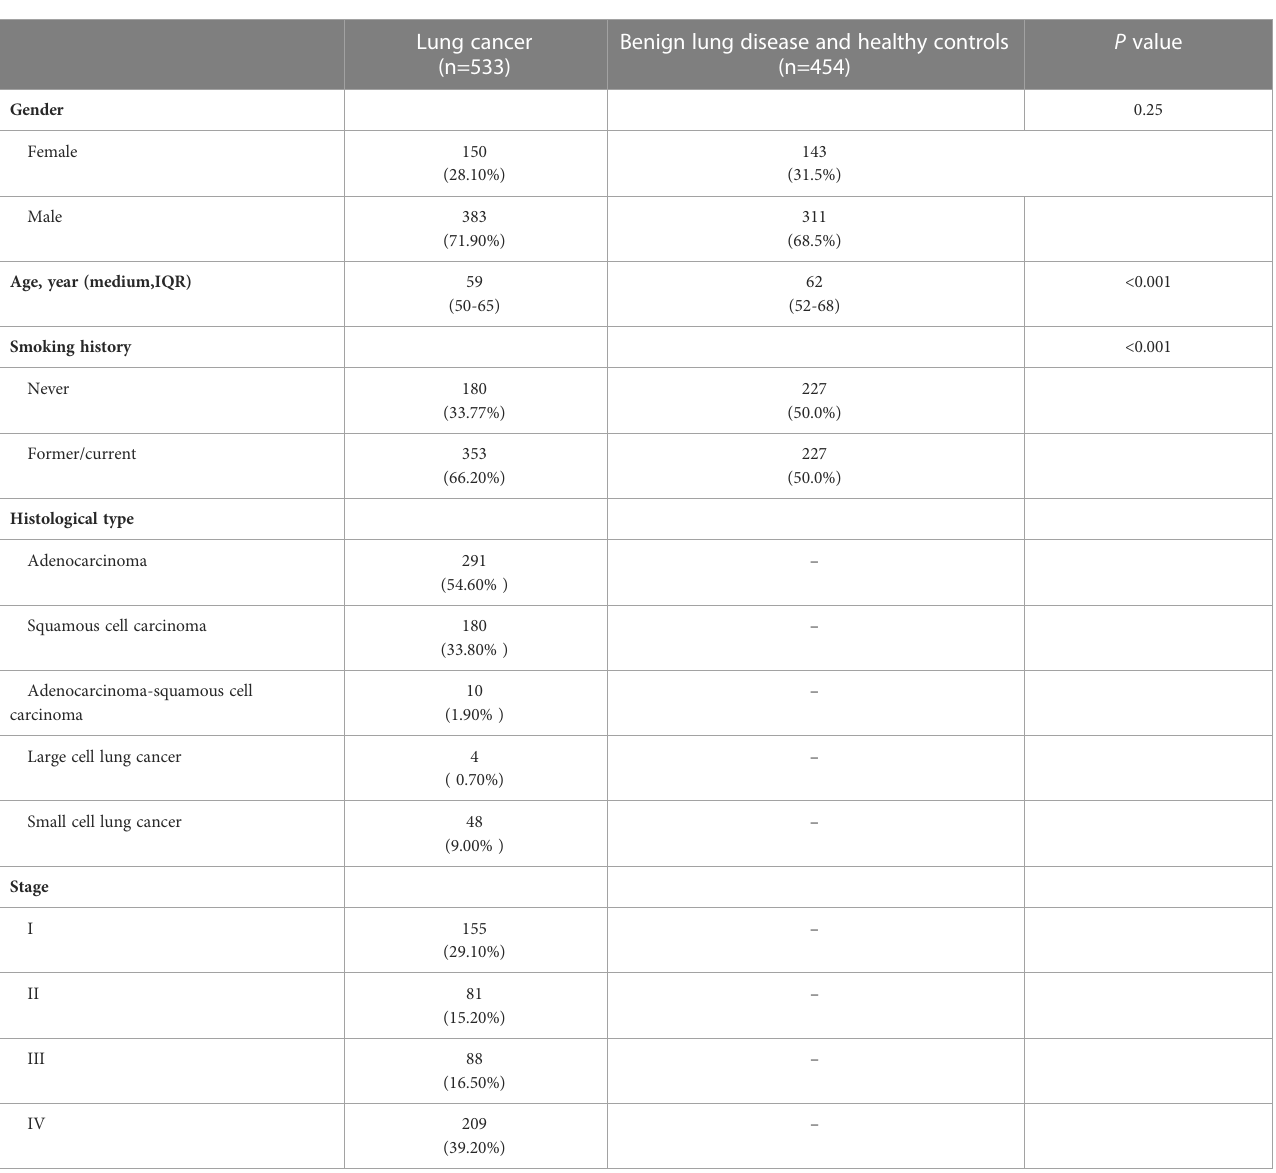
TABLE 1 Clinical and demographic characteristics of the lung cancer cases and